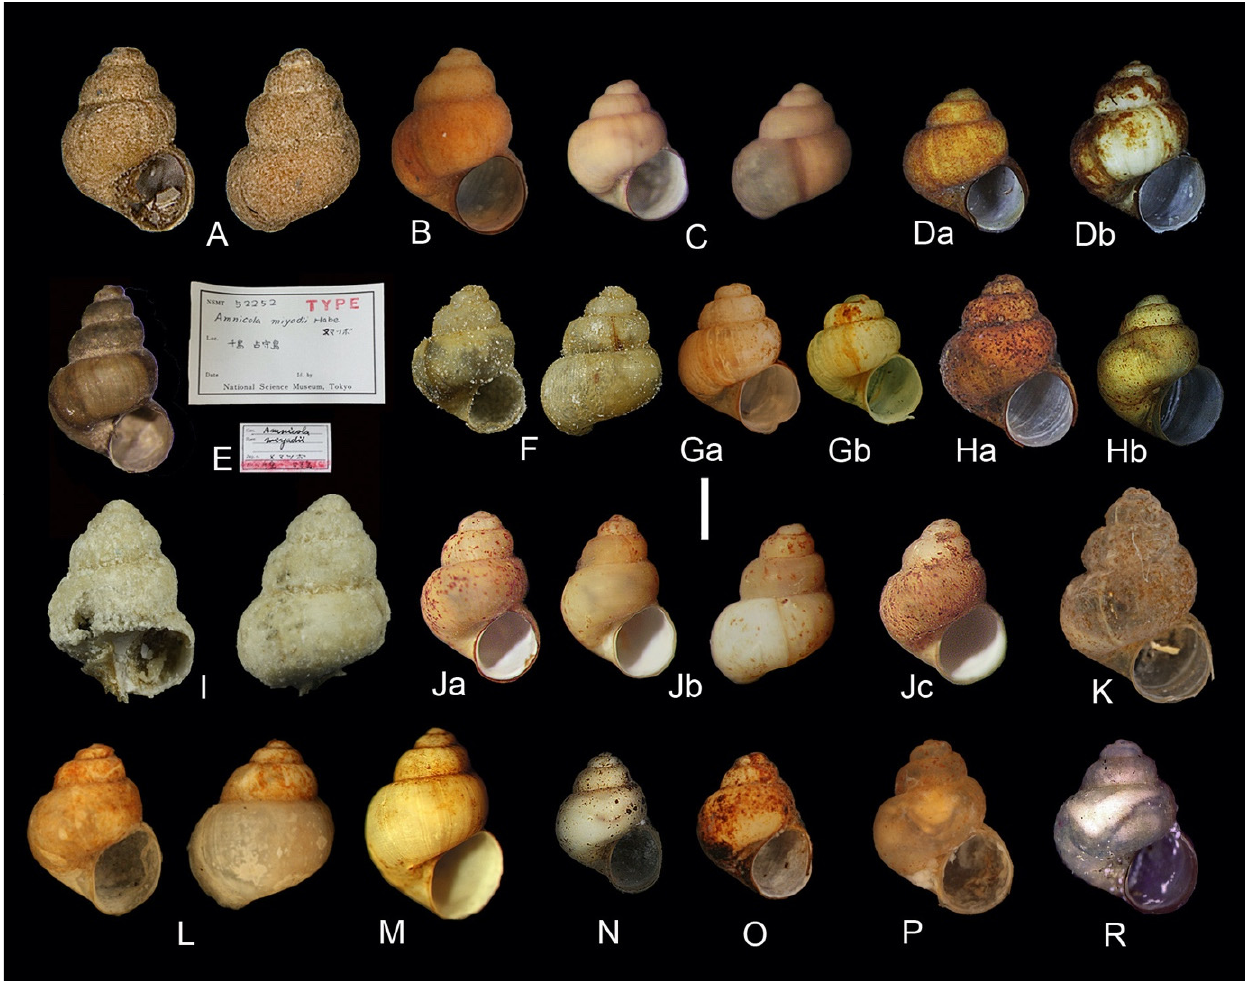
Figure 2. Shells of Kolhymamnicola species. ( A ) K. kolhymensis , paratype, ZIN No. 4. ( B ) K. kolhymensis , topotype, female, Lower Kolhyma River, near Chersky settlement, IBSS, No. 1418. ( C ) K. kolhymensis , female, an inlet of Lake Yama, Perevolochnaya valley, IBSS, No. 2120b. ( Da , Db ) K. kolhymensis , a lake near Anadyr city, Chukotka, IBSS, 1397. ( E ) K. miyadii , the type with the labels, NSMT. ( F ) K. miyadii , topotype, Bolshoe Lake, Shumshu Island, ZIN. ( Ga ) K. miyadii , topotype, female, the same lake, IBSS, No. 111-97. ( Gb ) K. miyadii , topotype, male, the same sample. ( Ha ) K. miyadii , female, Sredneye Lake on Zelenyi Island, IBSS, No. 518. ( Hb ) K. miyadii , male, the same sample. ( I ) K. ochotica , holotype, ZIN, No. 1. ( Ja ) K. ochotica , female, Kava River, Magadan Region, IBSS, No. 4325. ( Jb , Jc ) K. ochotica , males, the same locality. ( K ) K. ochotica , female, Lake Tynerynda, Yama River basin, IBSS, No. 2431. ( L ) K. wasiliewae , holotype, ZIN, No.1. ( M ) K. wasiliewae, female, topotype, Bolshoi Bolin River, near Amursk Town, IBSS, leg. L. Prozorova. ( N ) K. wasiliewae , male, Bolshoy In River, Amur River Basin, IBSS, leg. L. Prozorova. ( O ) K. wasiliewae , male, Upper Zeya River basin, IBSS, leg. L. Prozorova. ( P ) K. cf. wasiliewae Lake Leprindo, Baikal Rift Zone, male, LIN, leg. A. Matveev. ( R ) K. cf. wasiliewae , female, lake in the Lapagar terrain, vicinity of the Vitimsky Nature Reserve, LMBI, No. 05-031. Scale bars 1 mm.